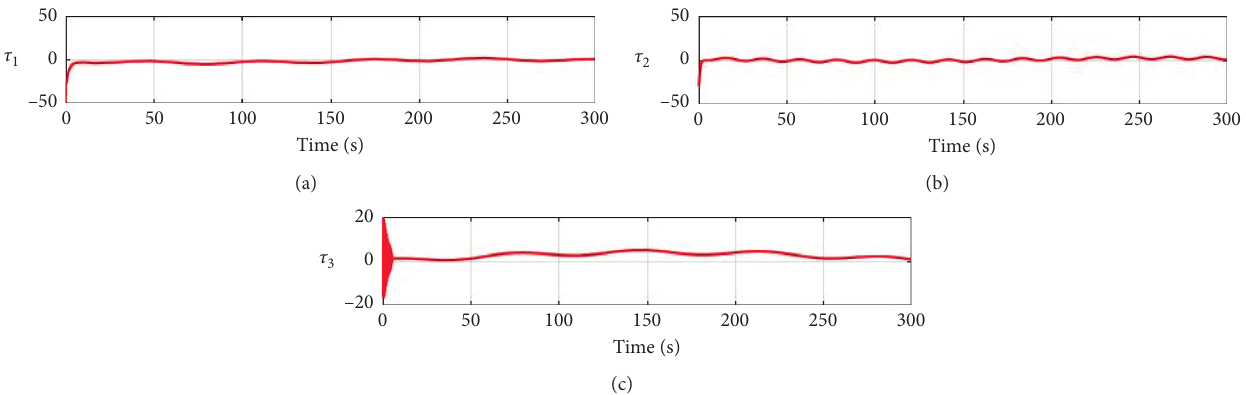
Figure 7: Trajectories of control input τ .